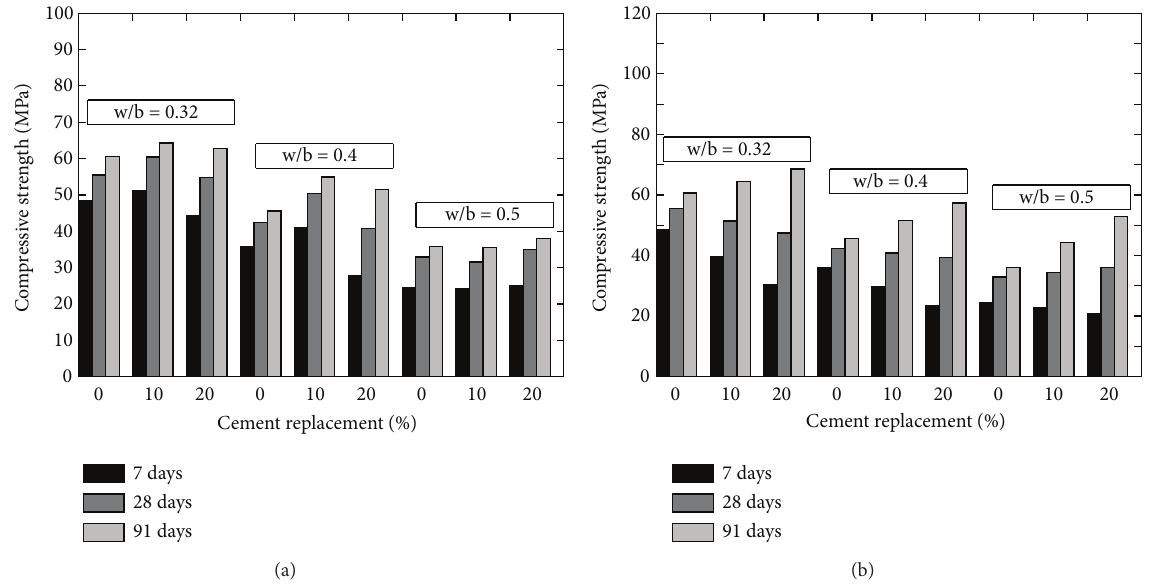
Figure 14: Effect of RHA imported from (a) USA (on left) and (b) Uruguay (on right) on the compressive strength [40].